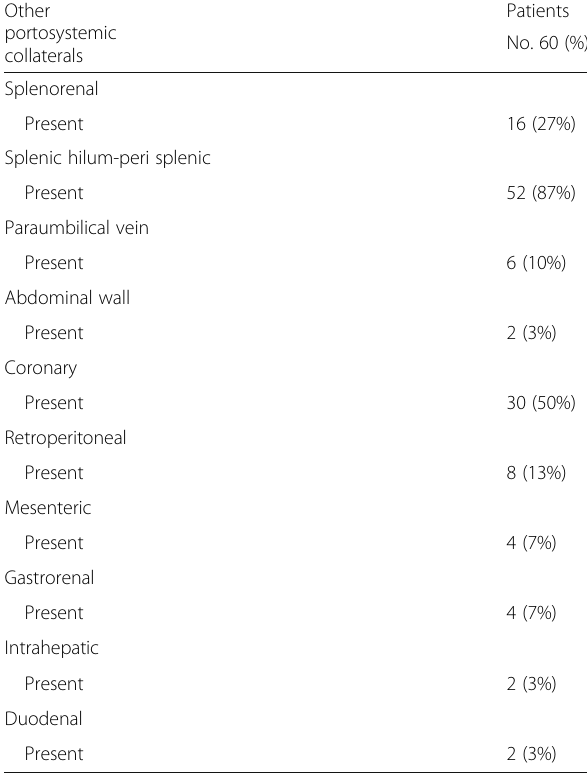
Table 2 Distribution of the studied patients regarding their other portosystemic collaterals